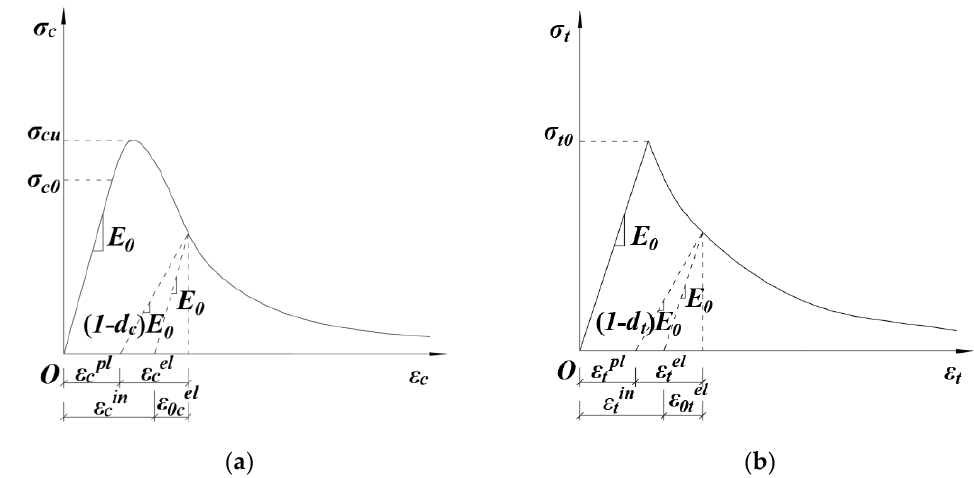
Figure 1. Uniaxial compression and tensile behaviour of concrete. ( a ) Stress-strain relationship of plastic damage under compression; ( b ) Stress-strain relationship of plastic damage under tension.